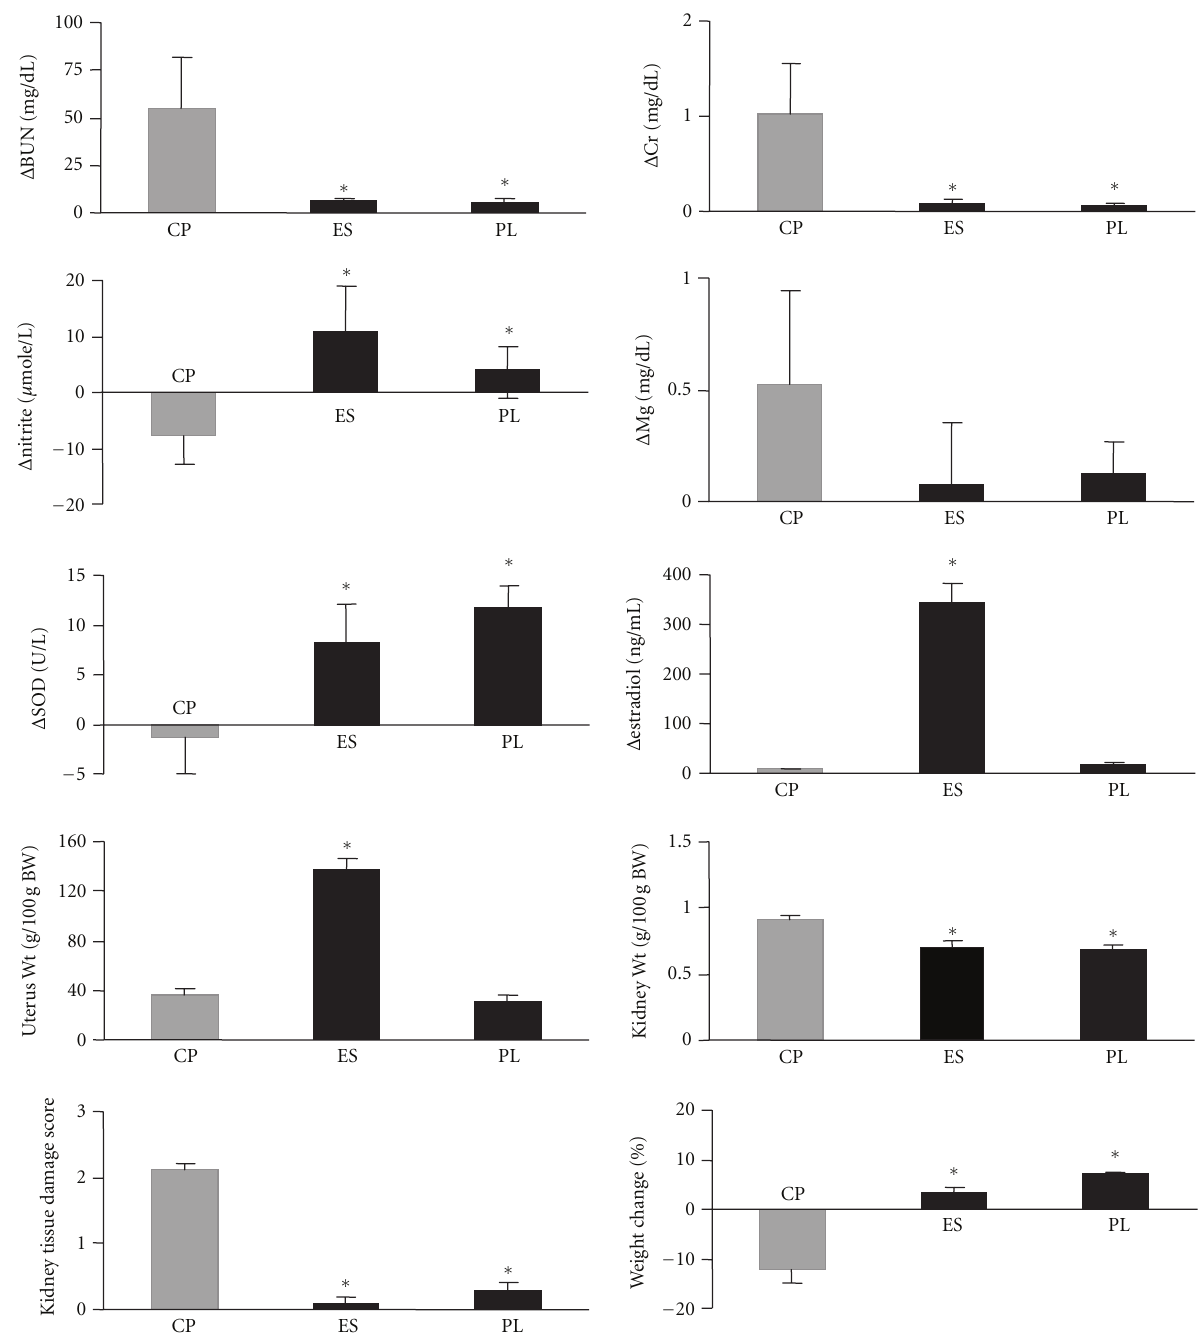
Figure 1: The serum di ff erence levels (one week after CP administration − before CP administration; Δ ) of BUN, Cr, Mg, SOD, estradiol, and nitrite; the kidney and the uterus weights; the KTDS in vehicle, estradiol, or CP (the positive control group) alone-treated ovariectomized groups. The star indicates significant di ff erence ( P < 0 . 05) when compared with the positive control groups. CP, ES, and PL on the horizontal axes stand for groups treated with CP (group 5), estradiol valerate (group 6), and vehicle (placebo, group 7),